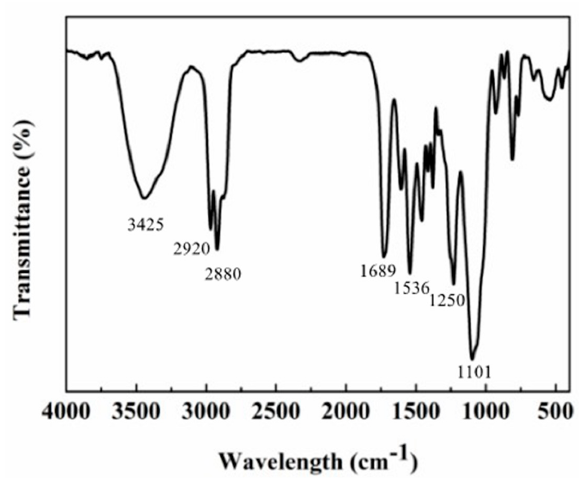
Figure 1. The FTIR spectra of PU-P after chain extension.